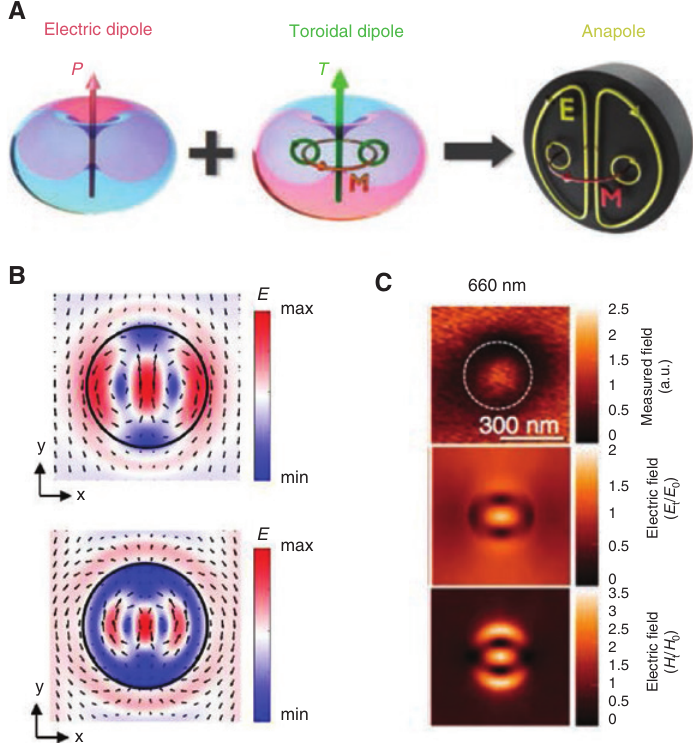
Figure 1: Physics and observation of the anapole state. (A) Conceptual representation of the anapole state as a superposition of electric dipole and toroidal dipole modes. A special feature of these two dipoles is that their far-field distribution is identical. For a particular set of parameters, these two dipoles can completely cancel each other by destructive interference in the far-field region when oscillating out of phase, hence creating a nonradiating anapole. (B) Numerical field structure of the two types of anapoles excited in a dielectric nanodisk. (C) Experimental SNOM measurements of the anapole state. The contour of the nanodisk is represented with a white dashed line. The middle and bottom images show the computed transverse electric and magnetic near-field, respectively, 10 nm above the nanodisk. Adapted with permission from Ref.